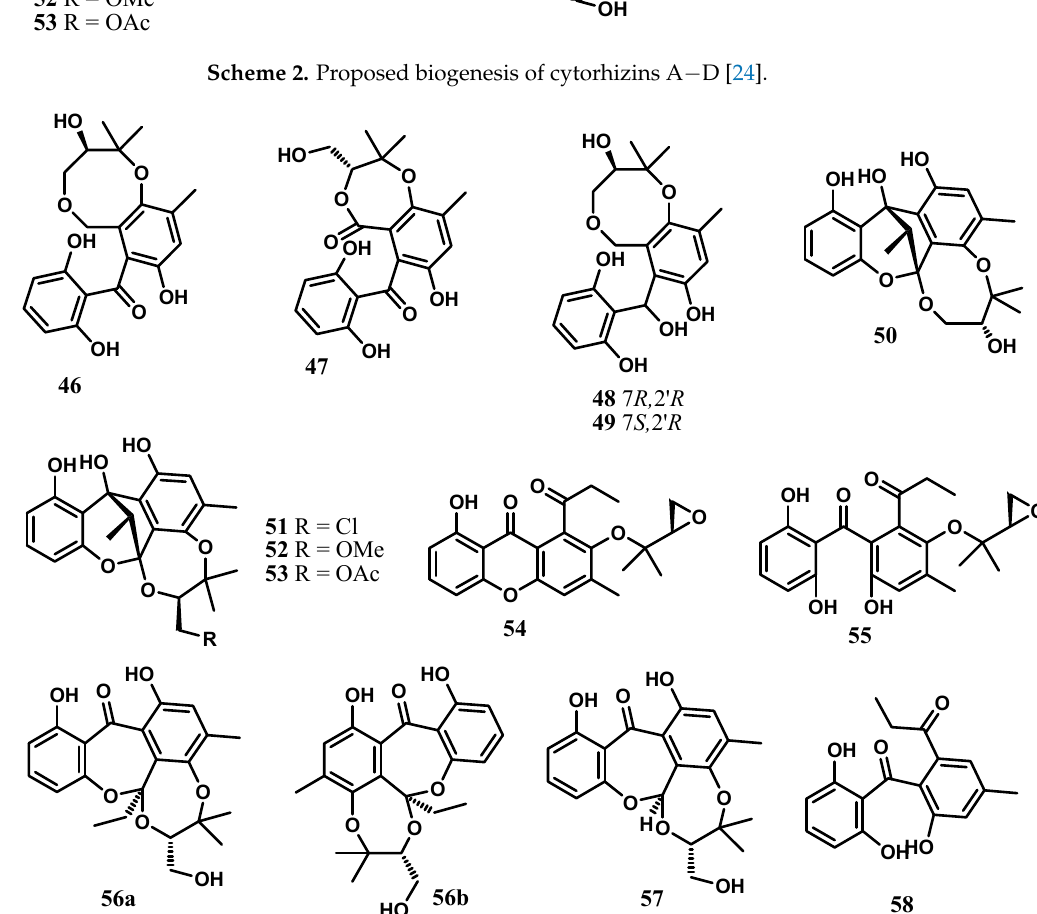
Figure 5. Benzophenones from the genus Cytospora